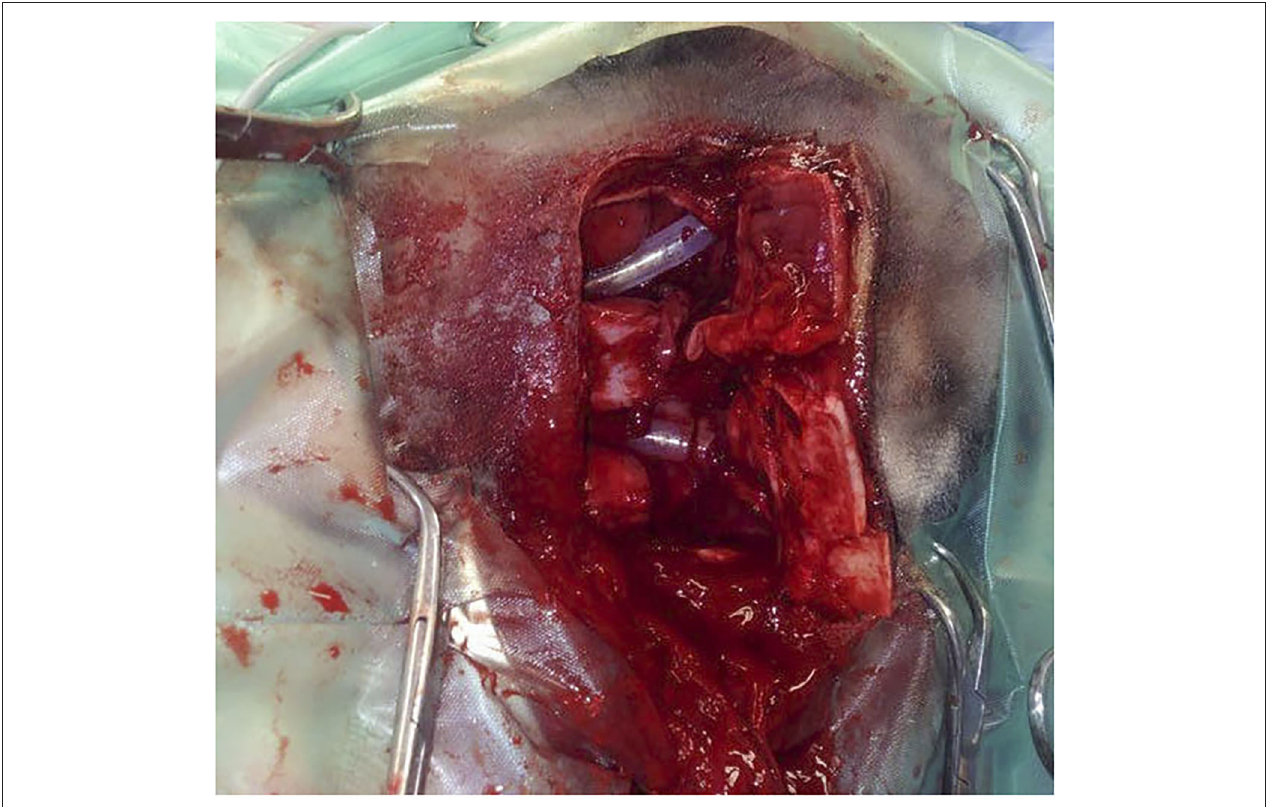
FIGURE 4 | Intra-operative dorsal view of a bilateral fronto-nasal bone flap osteotomy in a Miniature horse (case 3) with obstructive disease of the sino-nasal passages. Animal in left lateral recumbency. The bone flap is opened and silicone tubes have been introduced in both nasal passages after perforation of the medioventral wall of the dorsal